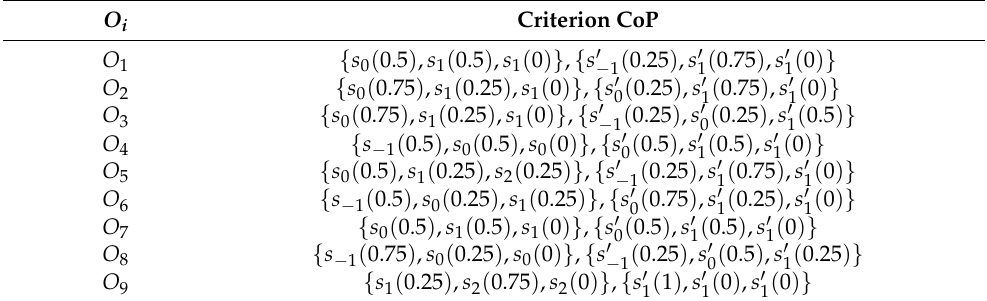
Table 10. Normalized qualitative matrix for criterion CoP.